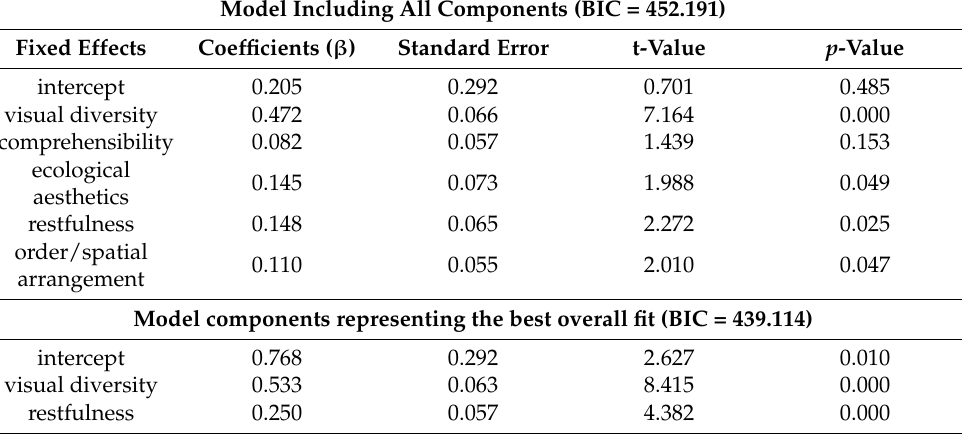
Table 5. Coefficients and significance values for linear mixed models (LMM) explaining the visual aes- thetics of forest views by (a) all components of perception and (b) the two most relevant components. (BIC—Bayesian information criterion, β —unknown coefficient of fixed effects, p -values—levels of significance).